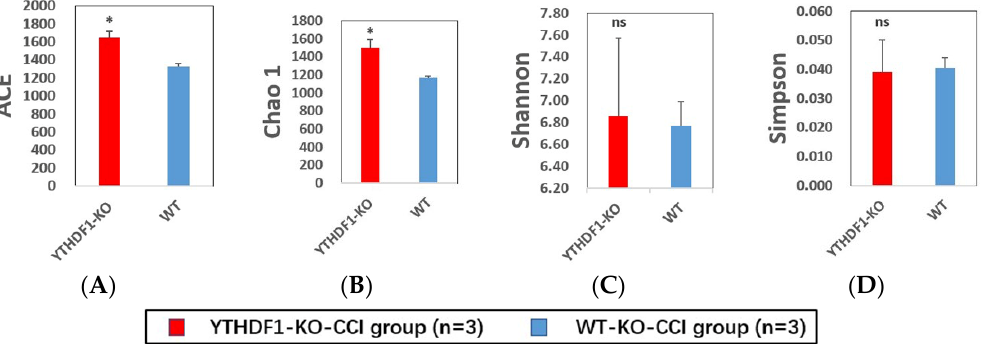
Figure 6. The comparison of alpha diversity of mycobiome in faecal samples of YTHDF1-knockout mice and WT mice at 3 days after CCI calculated by 4 different indices: ( A ) ACE index, ( B ) Chao1 index, ( C ) Shannon’s index, and ( D ) Simpson’s index. The bars indicate average diversity with the standard error of each group (YTHDF1-KO = YTHDF1-knockout) and statistically significant difference (* p < 0.05, ns = not significant).